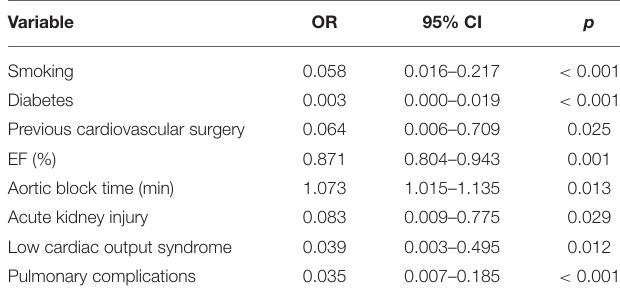
TABLE 1 | Univariate analysis of patients with type A aortic dissection ( n = 438). Variable